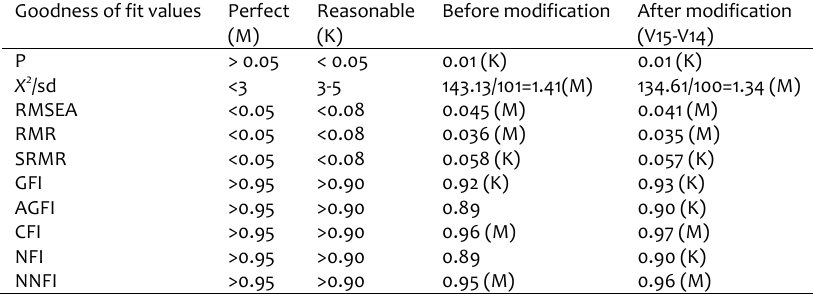
Table 5 - Results of Confirmatory Factor Analysis of the